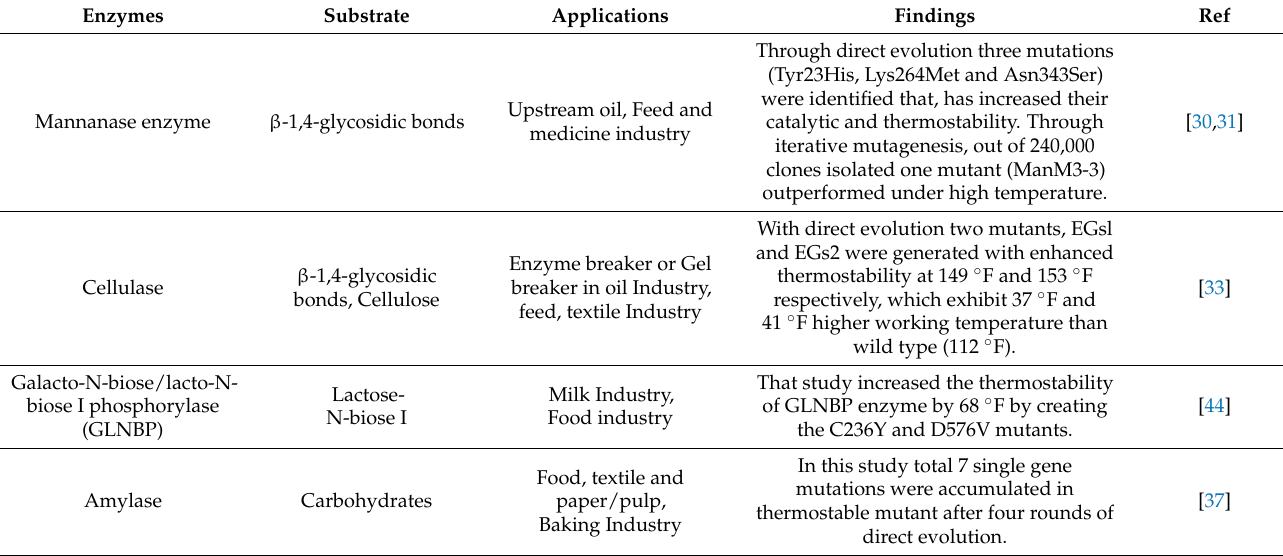
Table 2. Engineered thermostable enzymes are generated through direct